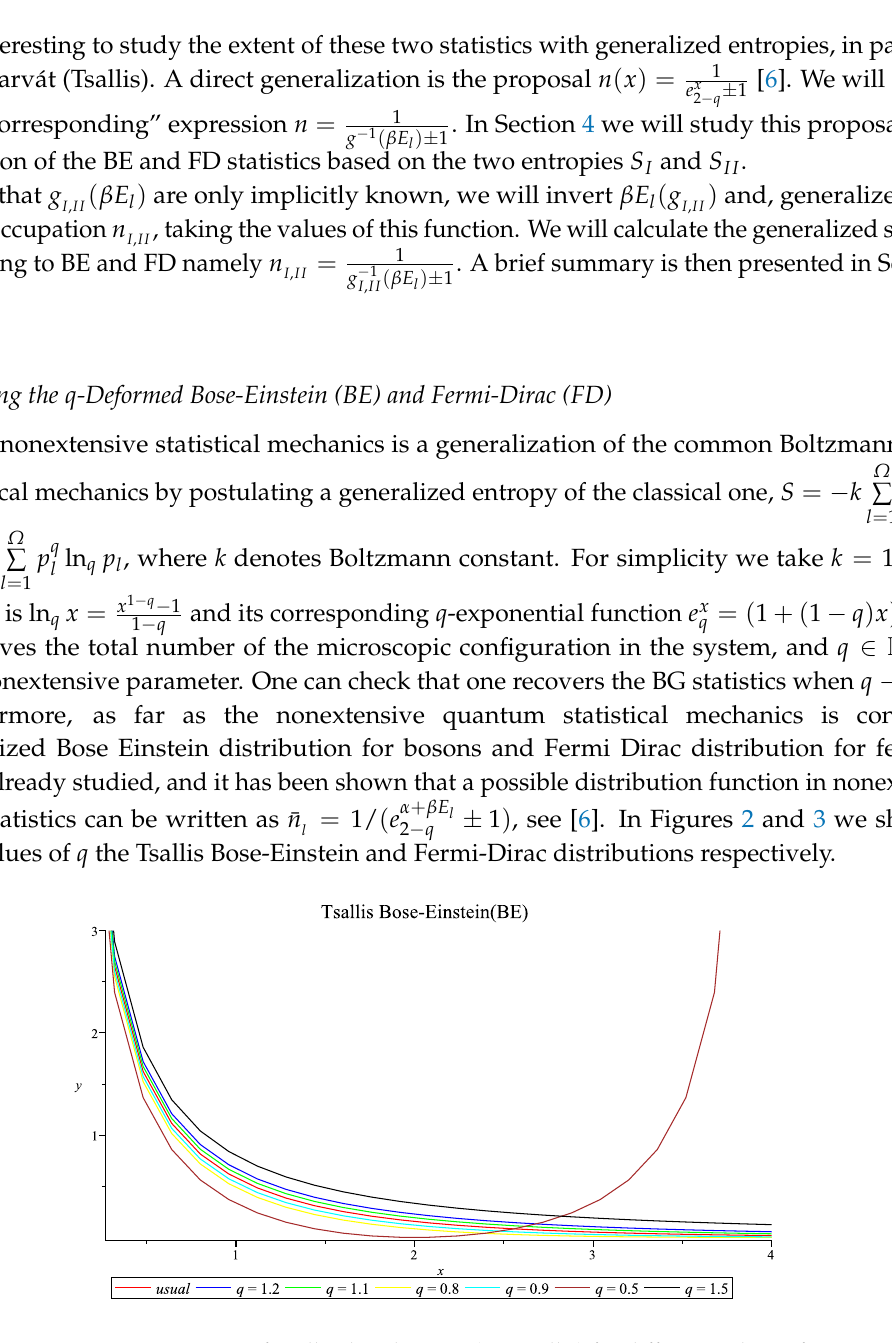
Figure 2. Comparison of Tsallis distributions (BE-Tsallis) for different values of q